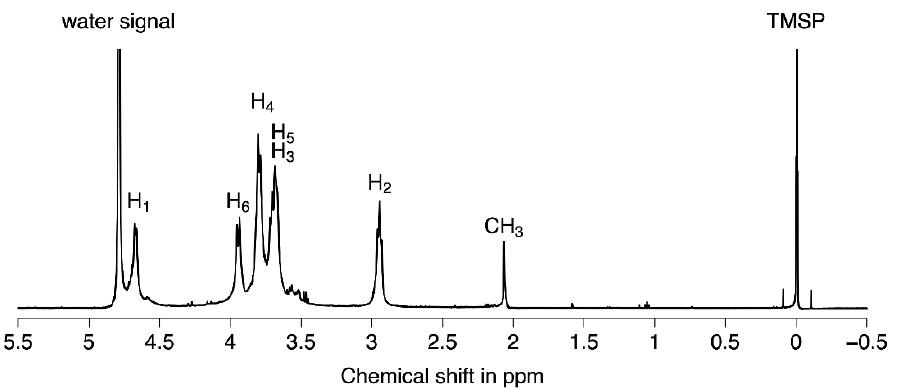
Figure 4. 1 H NMR spectra (600 MHz, in D 2 O) of COS oligosaccharides. The assignments of peaks were deduced from the literature [53].